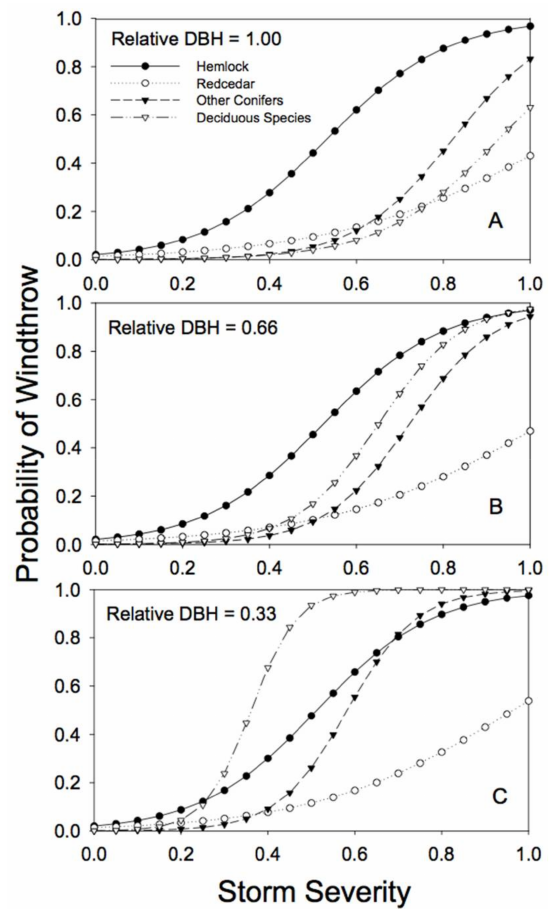
Figure 3. Predicted susceptibility to windthrow as a function of species and relative tree size for the 4 species groups in unlogged stands. The predictions were generated from Model 4a, using the parameters reported in Table 2, but with no prior harvest and for non-edge trees. ( A ) For trees with a relative DBH of 1.0; ( B ) for trees with a relative DBH of 0.66; ( C ) for trees with a relative DBH of 0.33. Relative DBH is the DBH of a tree as a fraction of the largest DBH tree in the